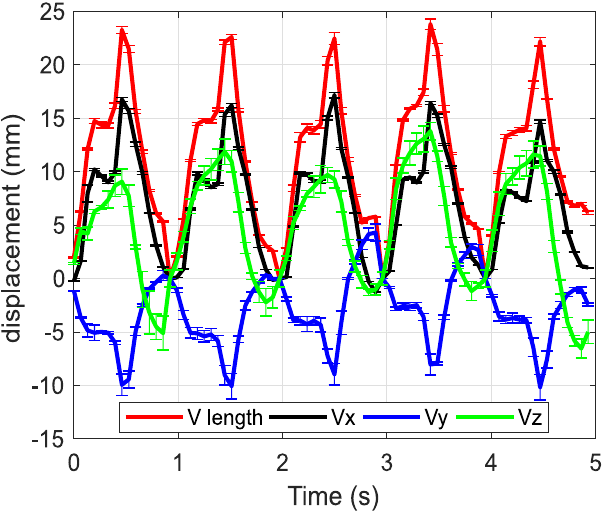
Figure 4. The length of the displacement vector and the components of the displacement vector obtained from the DIC analysis and the standard deviation error bars for each